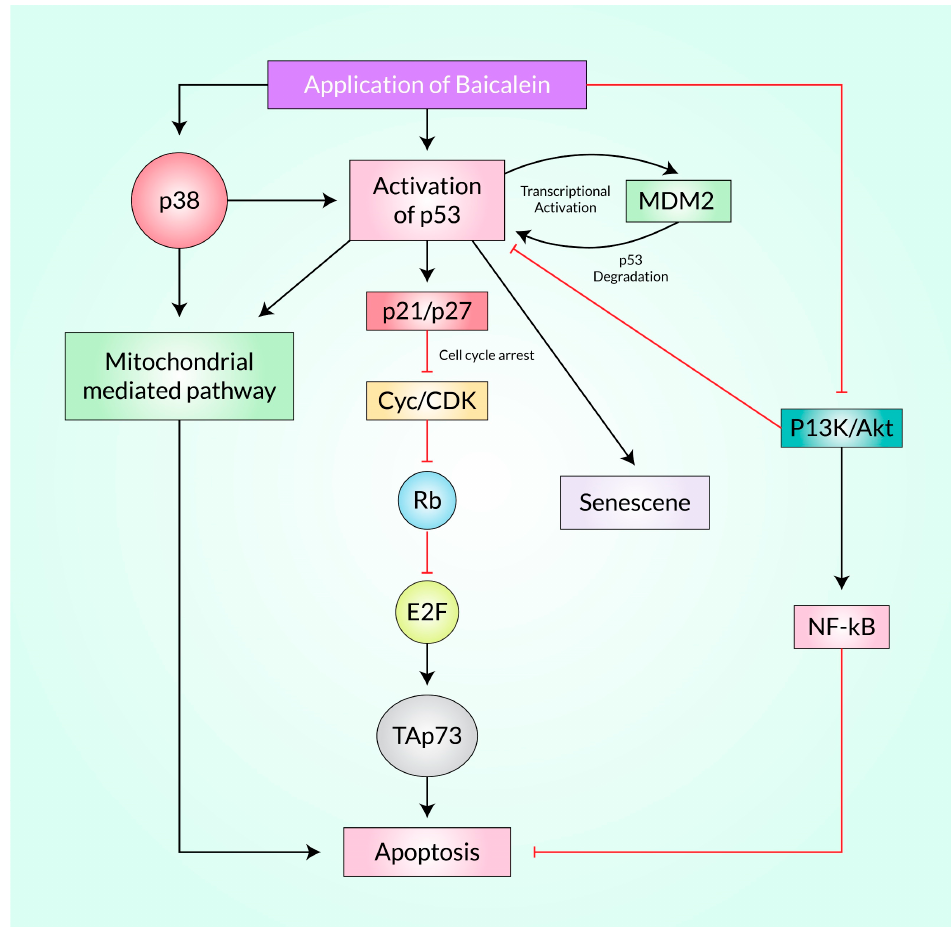
Figure 3. Baicalein increases the tumor suppressor proteins p38 and p53 and triggers apoptosis in tumor cells by inhibiting PI3K/Akt and subsequent proteins. Aditionally, this research highlights how Baicalein may impact cell cycle progression through the p53/Rb signaling pathway. Also, how MDM2-mediated degradation of p53 controls the senescence is depicted here. Here, TAp73 is a tumor suppressor and a structural homolog of p53. E2F is known as a transcriptional factor.